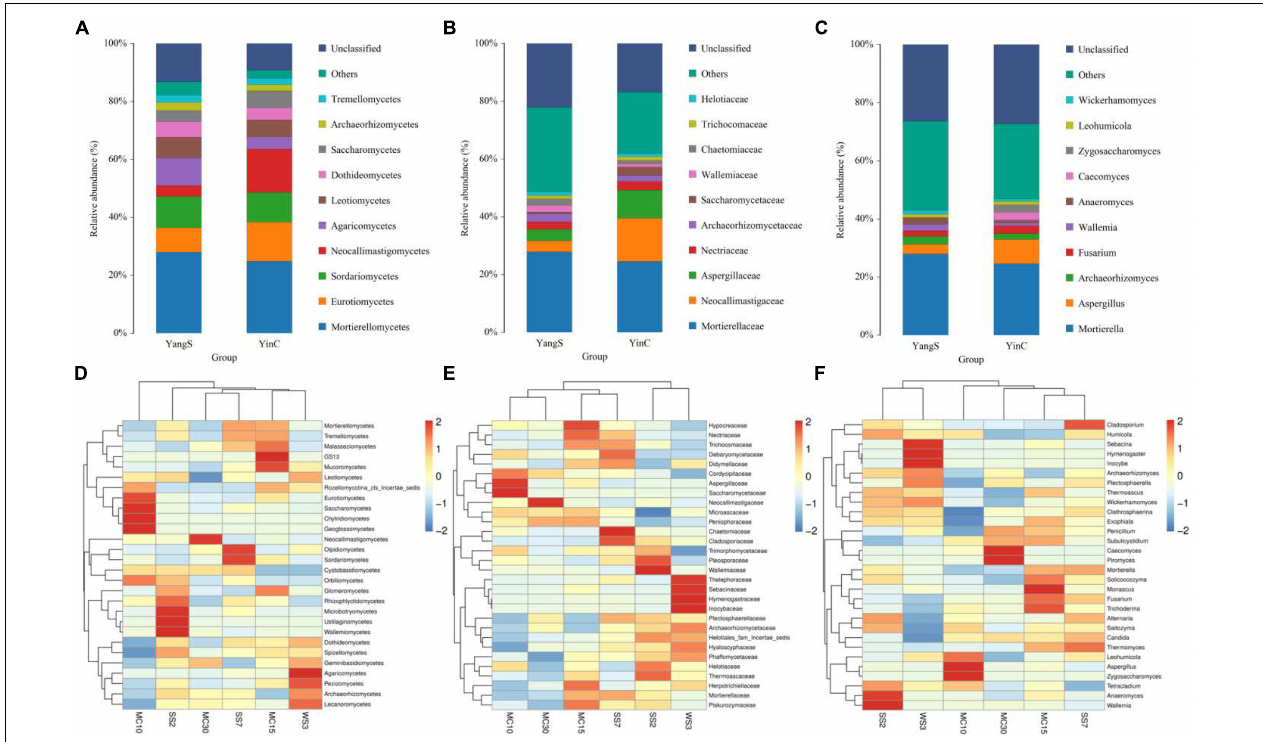
FIGURE 4 | The composition of fungal community in different groups. (A) Top 10 abundant taxa at class level; (B) top 10 abundant taxa at family level; (C) top 10 abundant taxa at genus level; (D) heatmap of species abundance clustering at class level; (E) heatmap of species abundance clustering at family level; (F) heatmap of species abundance clustering at genus level.